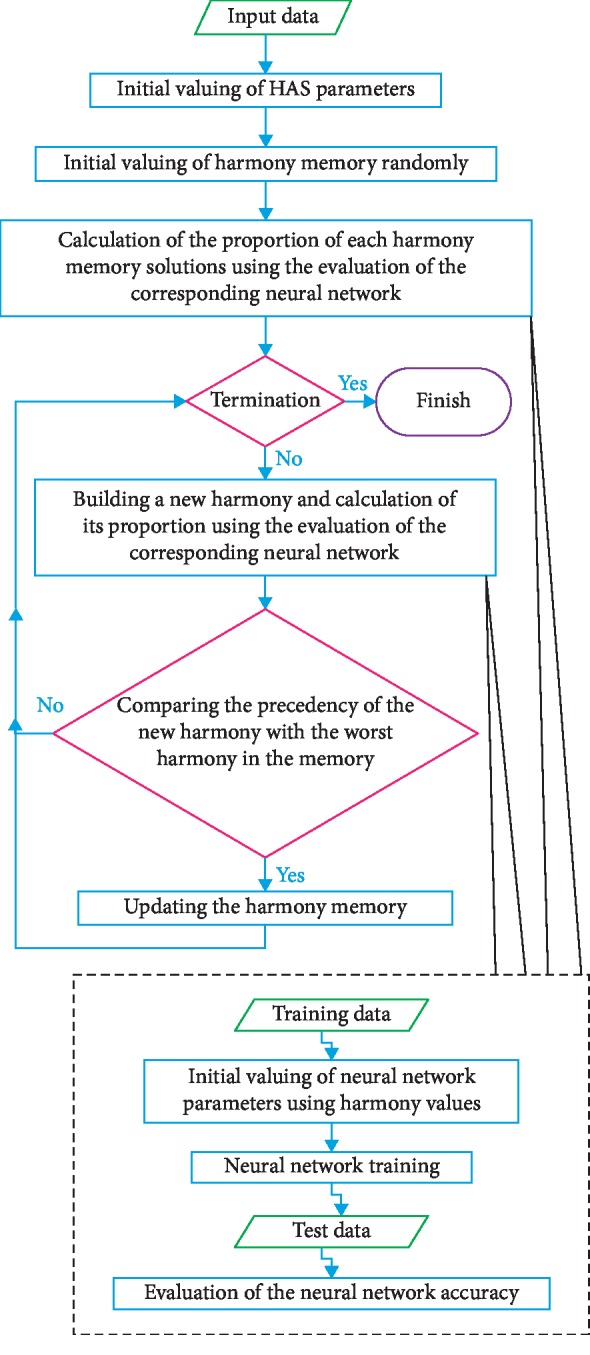
Flowchart of NNHS.